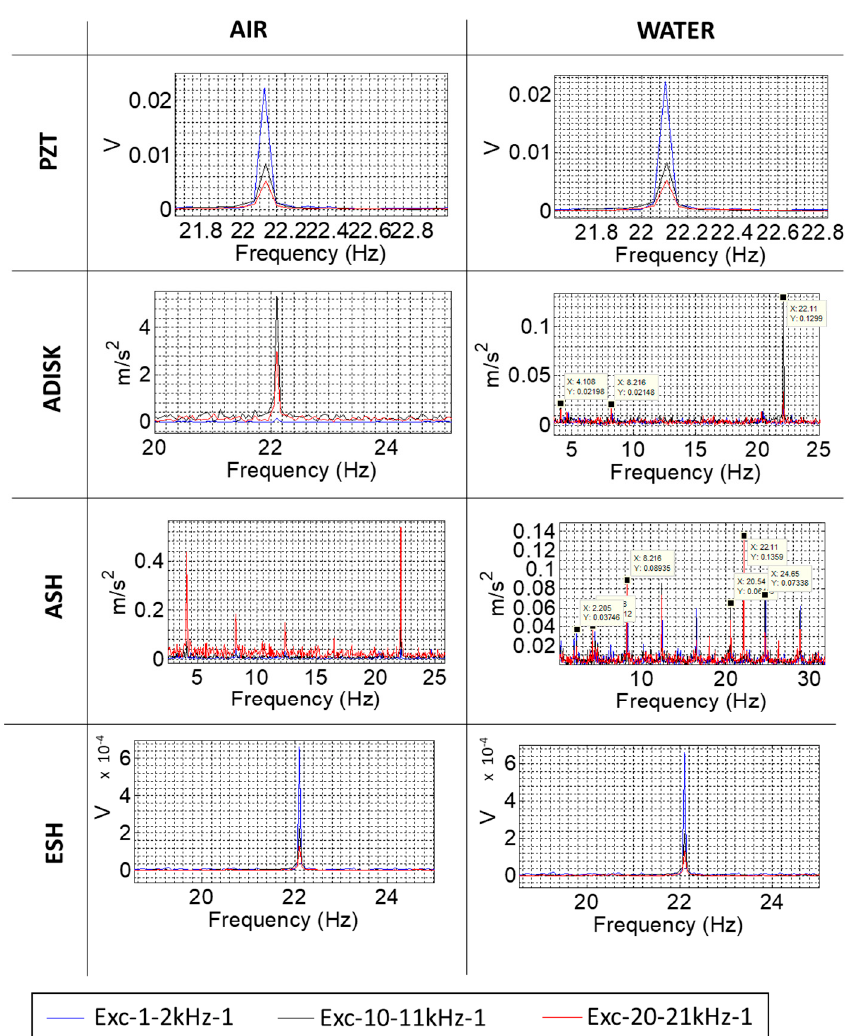
Figure 9. Amplitude demodulation for the sensors on the rotating frame and the excitation with one modulating frequency. Rotating case ( f f = 4.1 Hz).